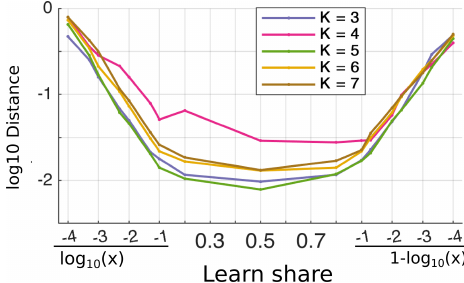
Figure 8. The average normalized distance of shifts of predicting centroids relative to learned centroids as a function of the share of the learning dataset. Averaging has been done from 30 trials. Differ- ent lines correspond to different numbers of initial clusters, K = 3– 7. The share of the learning dataset in the ranges of 10 − 4 –0.1 and 0.9–0.9999 is shown on a logarithmic